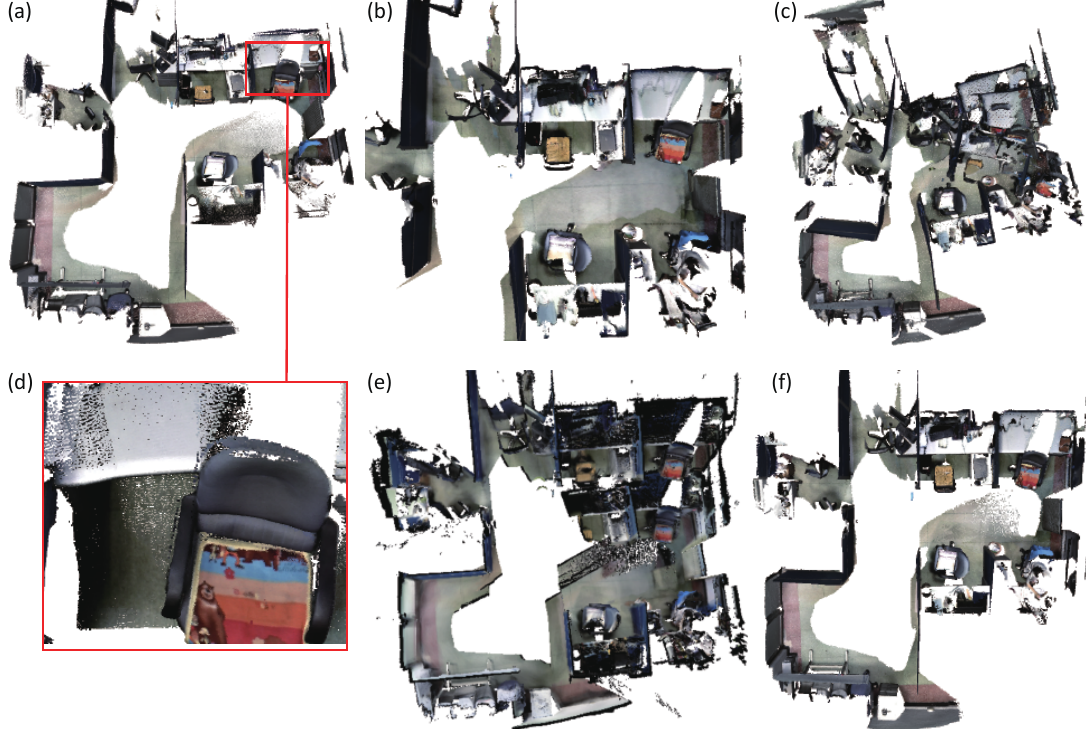
Figure 6. The reconstruction results of an office room. ( a ) is the 3D model generated by ElasticFusion [11,12]. The desk surface is deformed as displayed in ( d ). ( b ) is produced by BundleFusion [33]. ( c ) is generated by Kintinuous [36]. ( e ) is yielded by InfiniTAM v3 [39]. Our system produces good results as displayed in ( f